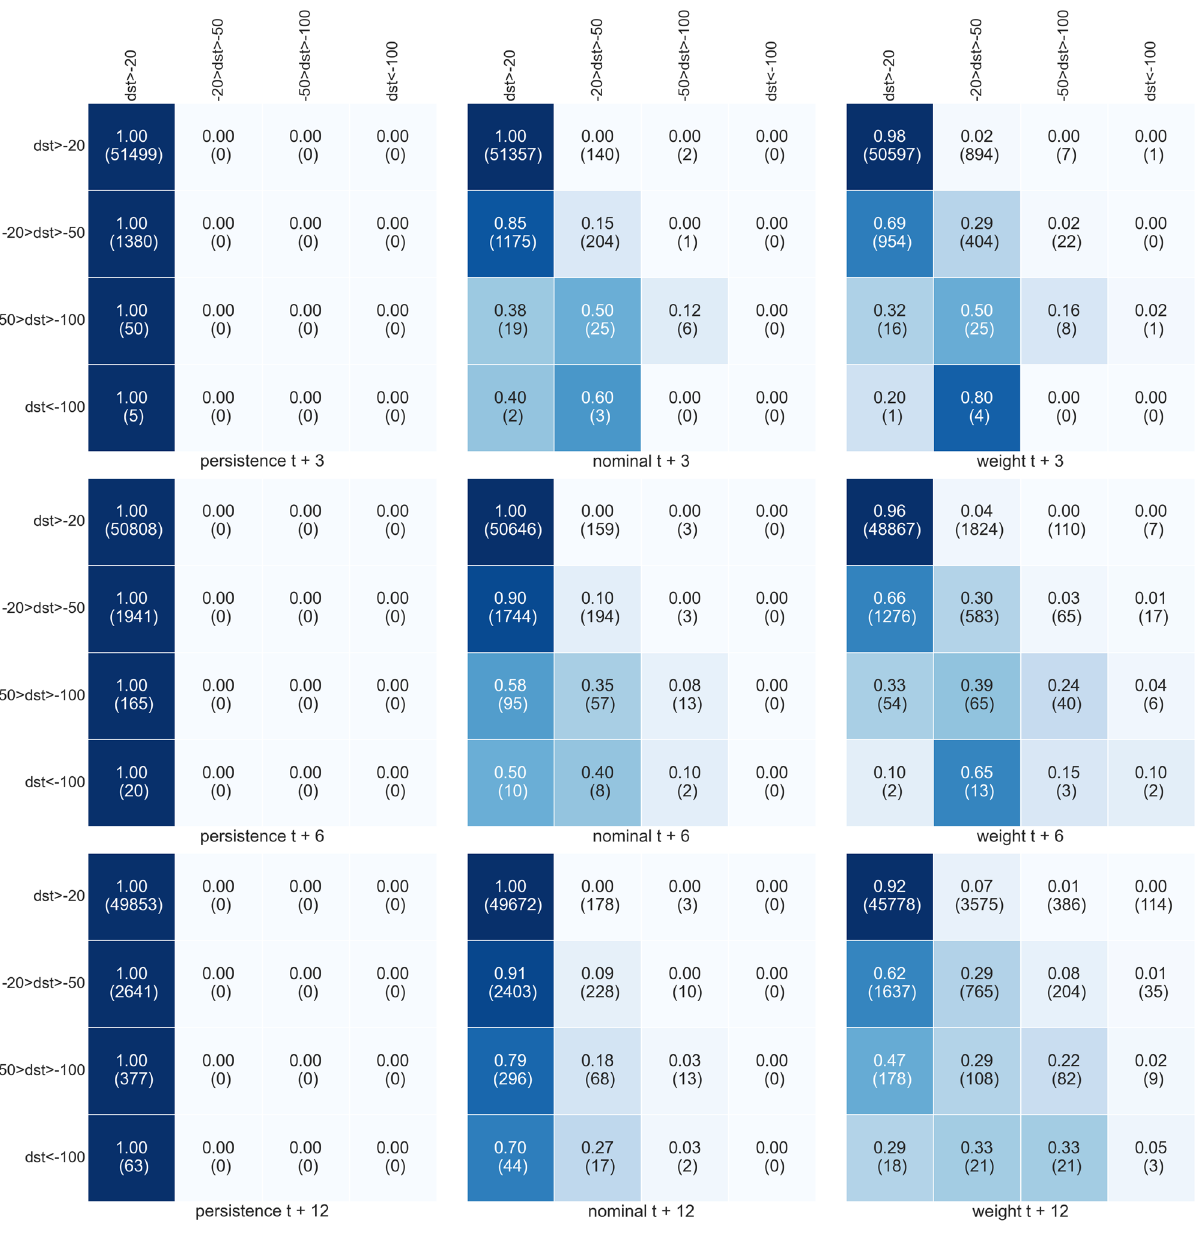
Figure 6. Same as Fig. 5 but only selecting input data where elements have Dst all larger than − 20